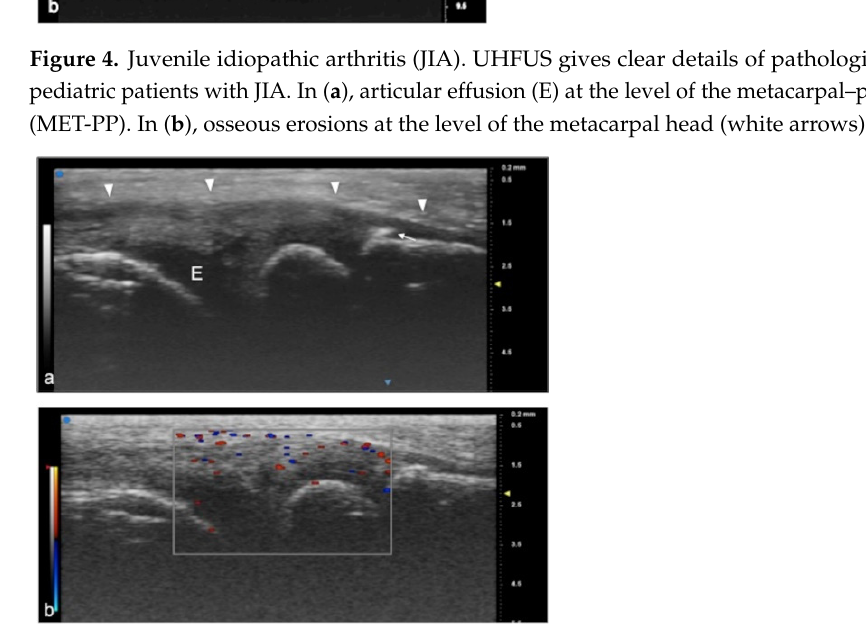
Figure 5. Juvenile idiopathic arthritis. UHFUS gives clear details of pathological findings in pediatric patients with JIA. In ( a ), articular effusion (E) at the level of wrist and enthesophyte (white arrow). Thickened capsule (arrowheads) in ( a ) presenting with an increased Doppler signal (white square) in ( b ).